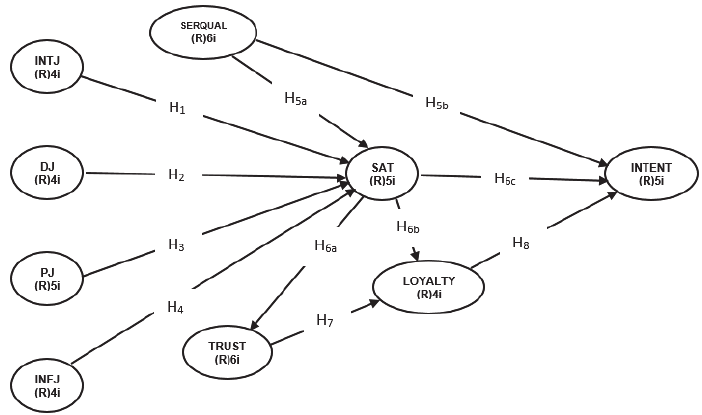
Fig. 1. Conceptual